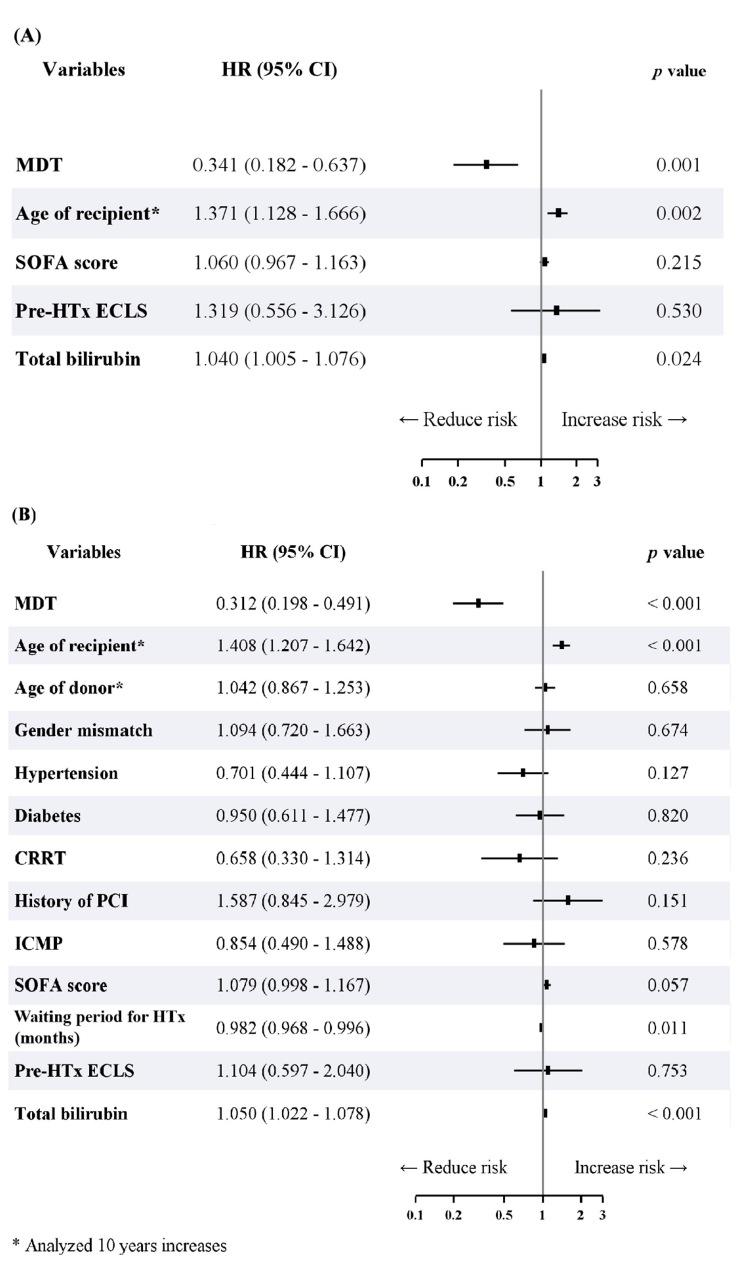
Figure 4. Forest plot based on the results of multivariable analysis of overall mortality ( A ) before adjustment using IPTW and ( B ) after adjustment using IPTW. IPTW, inverse probability of treatment weighting; HR, hazard ratio; CI, confidence interval; MDT, multidisciplinary team; SOFA, Sequential Organ Failure Assessment; HTx, heart transplantation; ECLS, extracorporeal life support; CRRT, continuous renal replacement therapy; PCI, percutaneous coronary intervention; ICMP, ischemic cardiomyopathy.